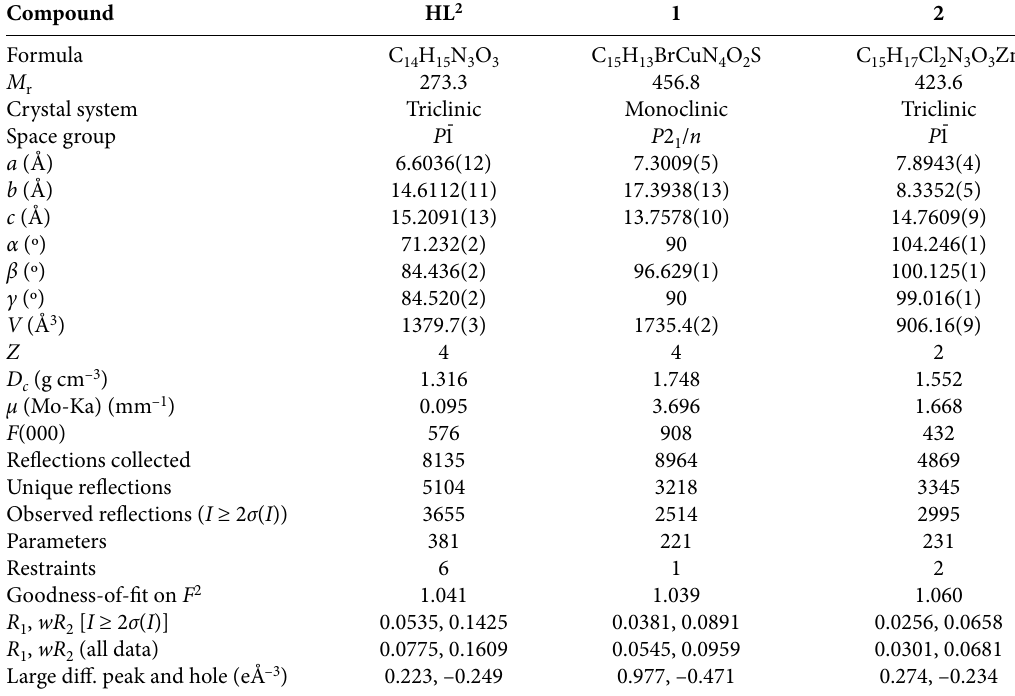
Table 1. Crystallographic and experimental data for the compounds